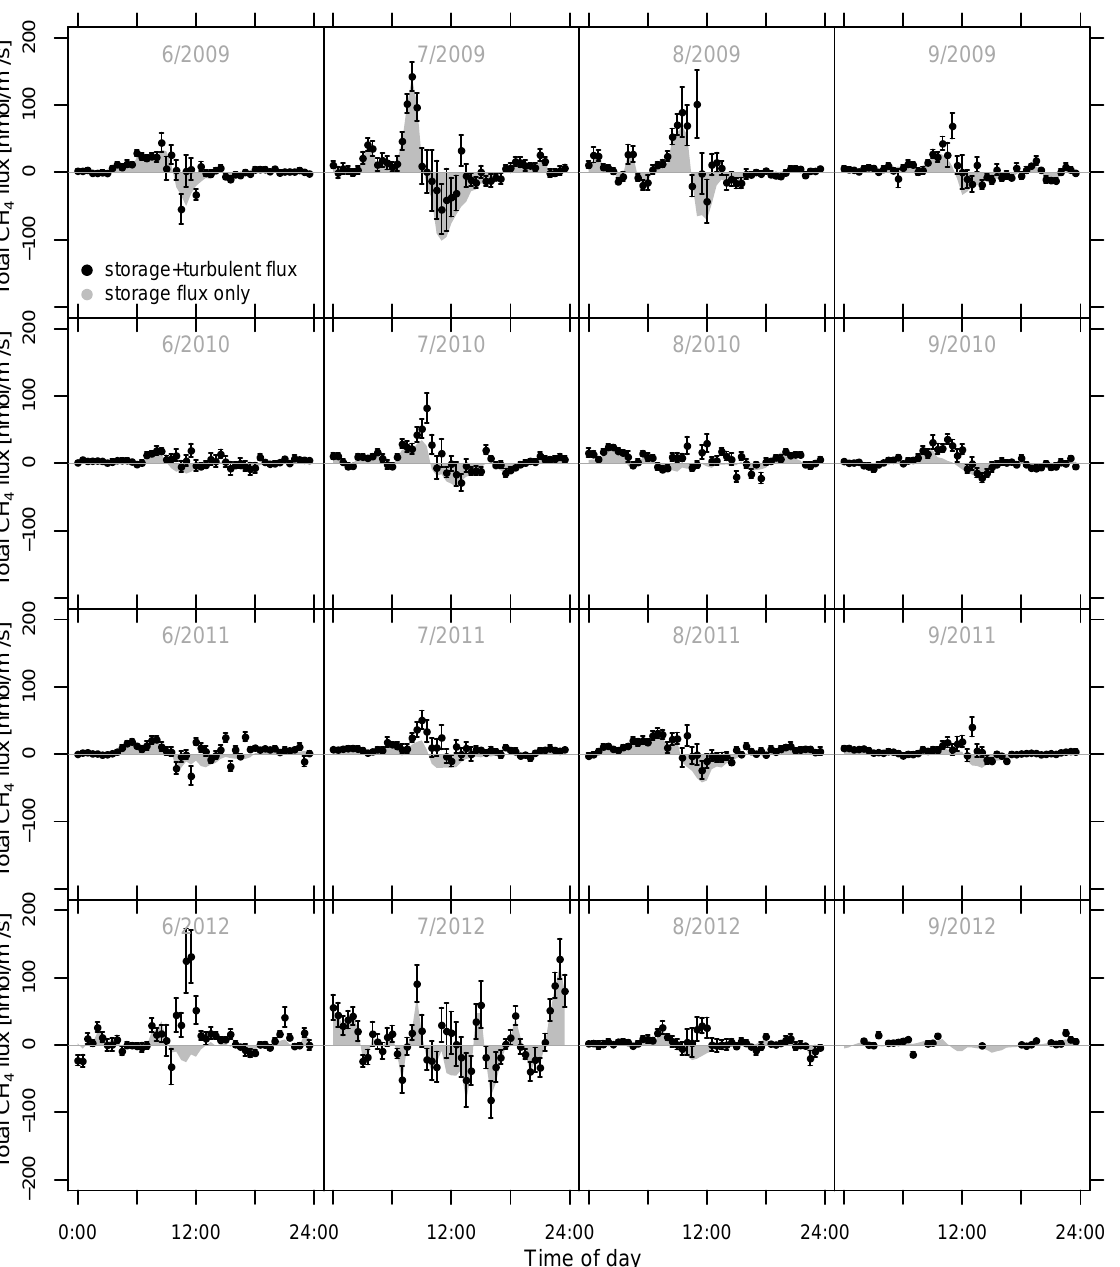
Fig. 9. Diurnal cycle of the total CH 4 flux estimate with standard deviation of the mean for all summer months in black: the grey area indicates the storage flux